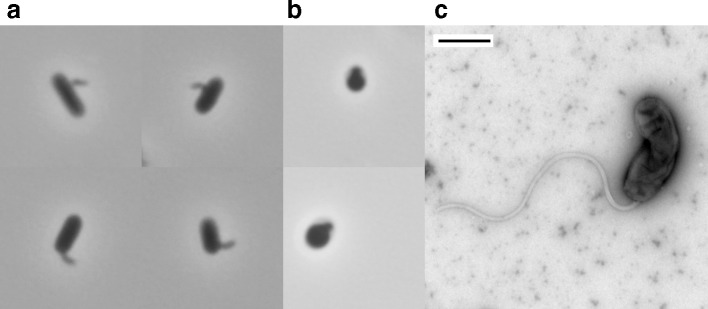
Microscopy of
Bdellovibrio
 sp. NC01 isolated from bioswale soil. (a) Compilation of four images taken using 1000x phase-contrast microscopy to show small, comma-shaped NC01 attack phase cells attached to larger
E. coli
 ML35 cells after 48 h of co-culture. (b) Compilation of two images taken using 1000x phase-contrast microscopy to show rounded structures characteristic of bdelloplasts after 48 h of co-culture. (c) Negative stain electron microscopy of a NC01 attack phase cell. The scale bar is 500 nm.